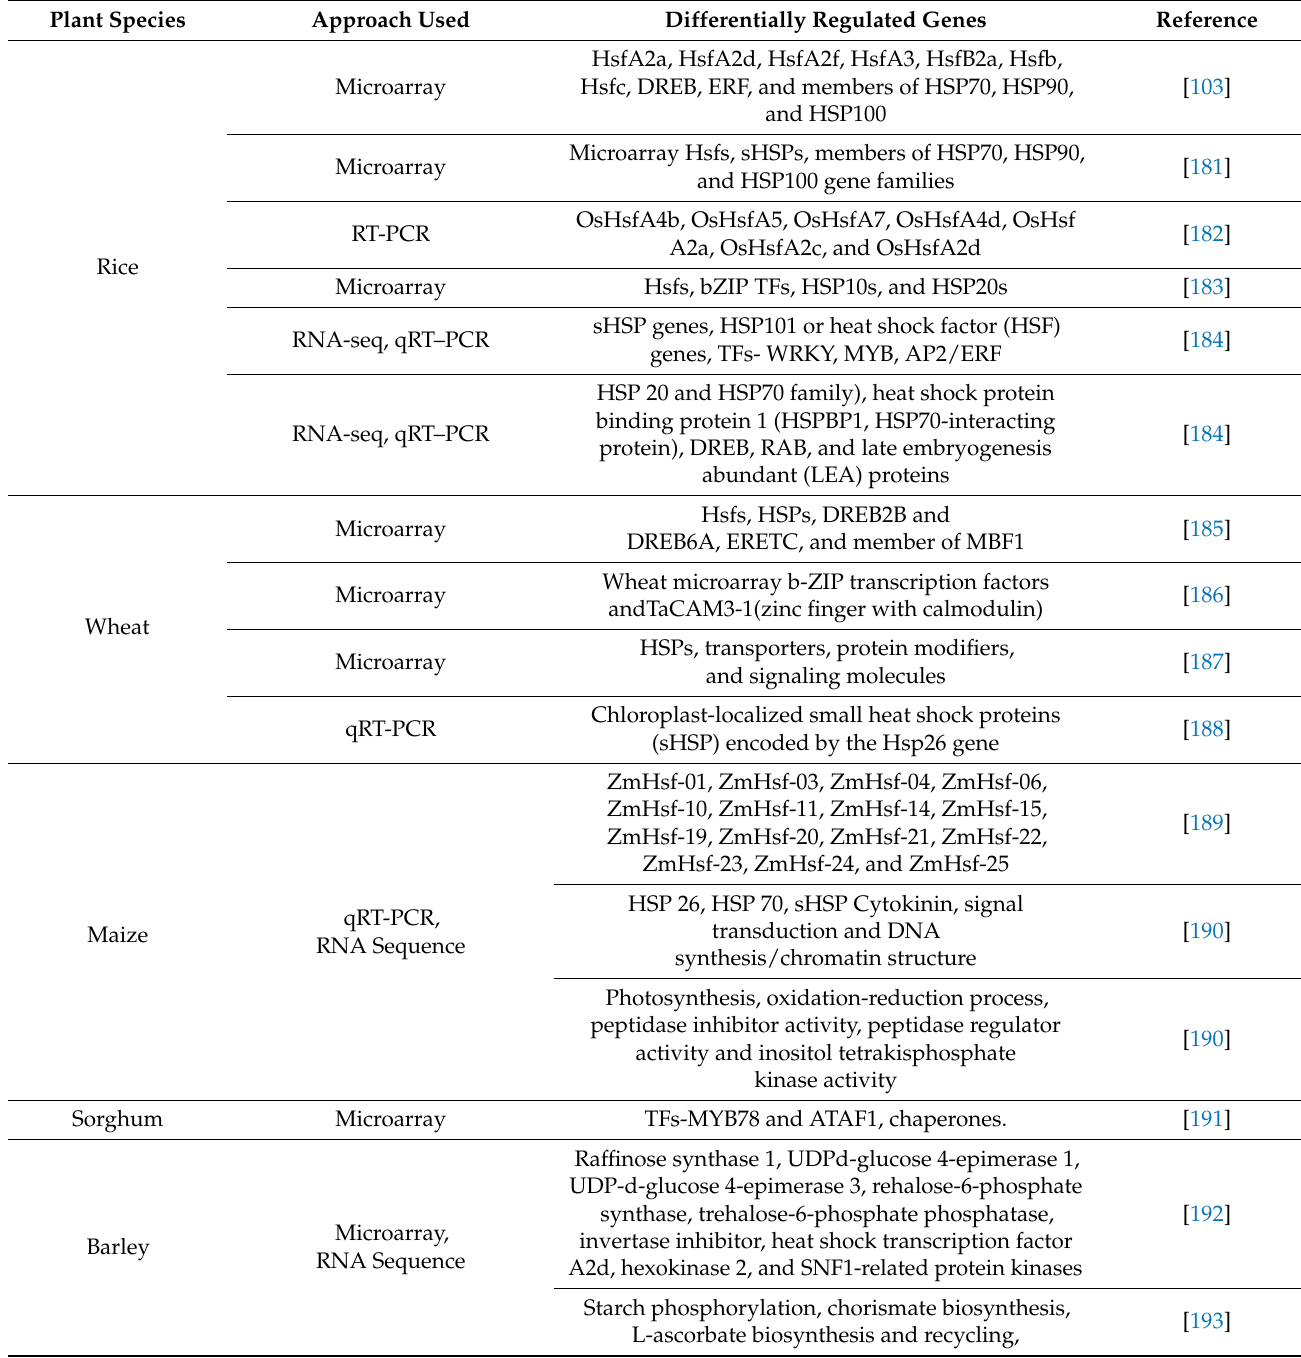
Table 3. Transcriptomics approaches to understanding the heat-stress induced responses in important